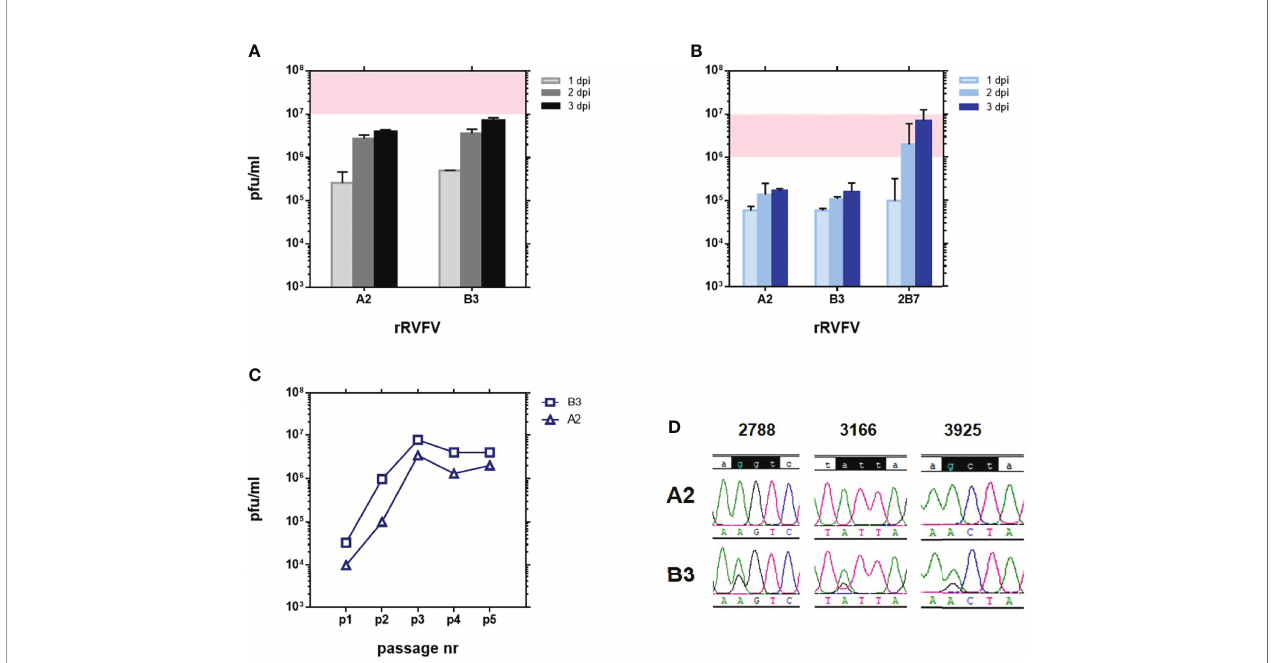
FIGURE 2 | Growth in cultured cells of RVFVs rA2 and rB3 carrying substitutions G924S & A1303T in the RdRp. Viral yield at 24, 48 and 72 hpi after infection at a MOI of 0.01 in (A) Vero and (B) HEK293T cells. Although coming from an independent experiment, a shade has been depicted to allow for a comparison with results shown in Figure 1 . In HEK293T infections, rZH548-P82L virus 2B7 was included for a comparison. Experiments were performed in duplicate. (C) Titer of supernatants collected at 72 hpi in serial passages (1 to 5) on Vero cells at a MOI of 0.01. Viral yields were determined by a plaque assay on Vero cell monolayers. (D) Sequence analysis of the RT-PCR product of viral RNAs recovered after 5 passages on Vero cells. The three nucleotide positions under study, 2788, 3166 and 3925, are shown. In the upper line, the wt sequence (rZH548) on the codons corresponding to residues 924, 1050 and 1303 is